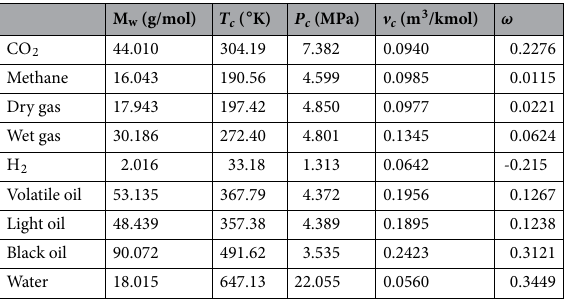
Table 1. Component properties of hydrocarbon gases, hydrogen, CO 2 and water 7,9–11 . M W = molecular weight, T C = critical temperature, P c = critical pressure, v c = critical volume, ω = acentric factor.